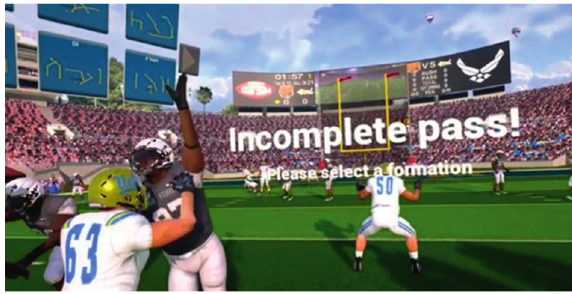
Figure 6: QB SIM simulation training